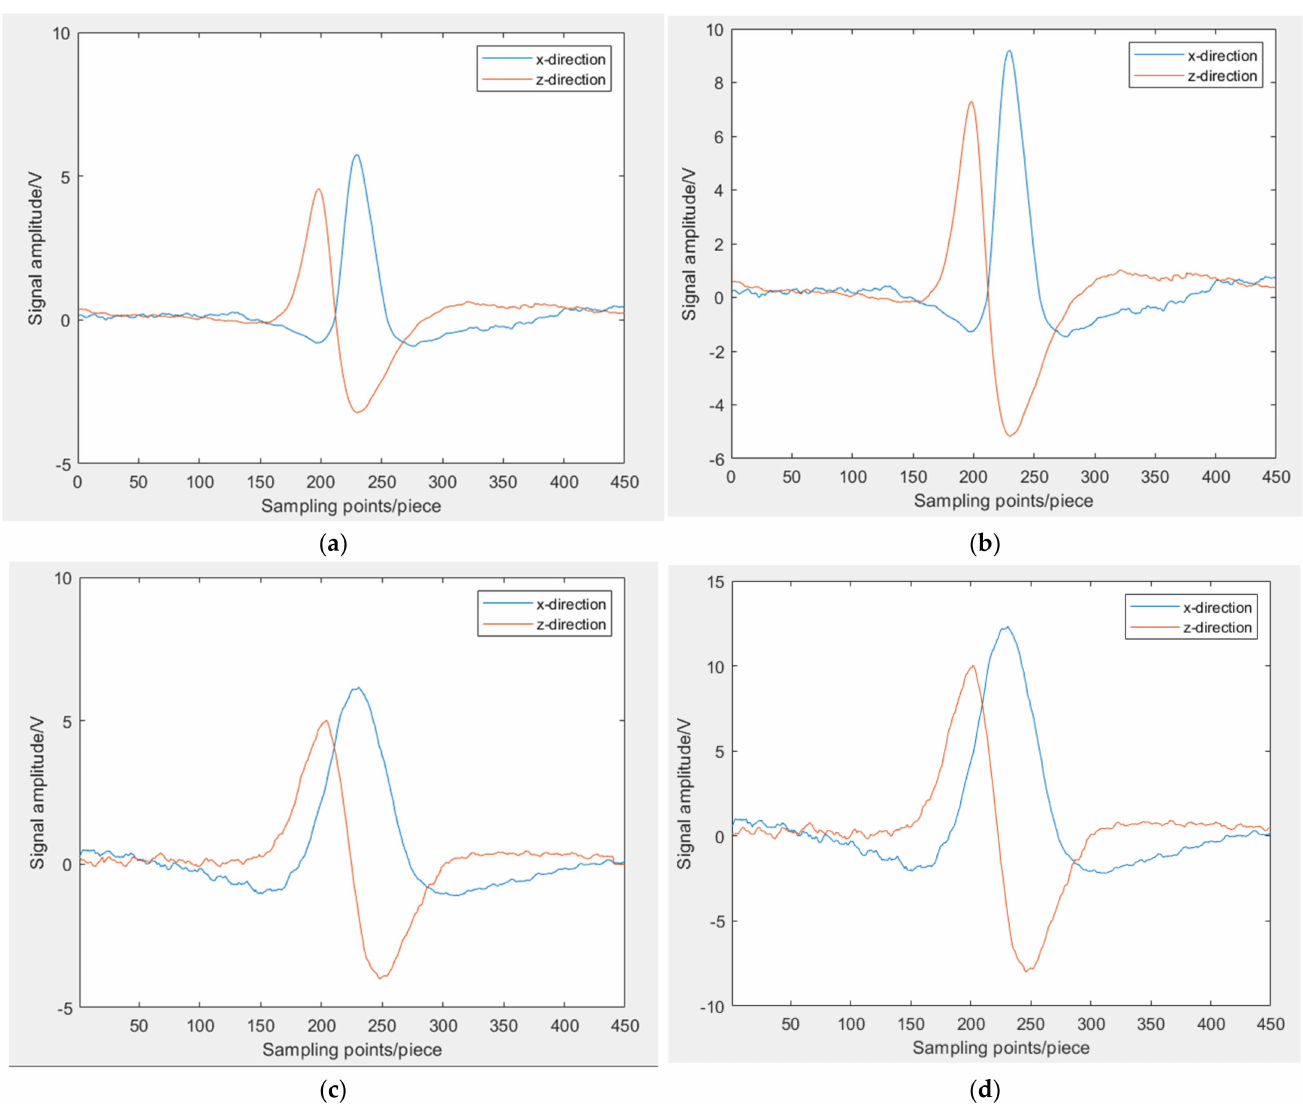
Figure 11. Detection results with different defects. ( a ) width = 2 mm, depth = 1 mm; ( b ) width = 2 mm, depth = 2 mm; ( c ) width = 3 mm, depth = 1 mm; ( d ) width = 3 mm, depth = 2 mm. A used rail with eight artificial defects is detected, and a wire is tied to the rail also, as shown in Figure 12. The width and depth of each defect are shown in Table 1. The lift-off of the sensor is also fixed at 2.0 mm. The distance between the two sensors is 2.2 mm.